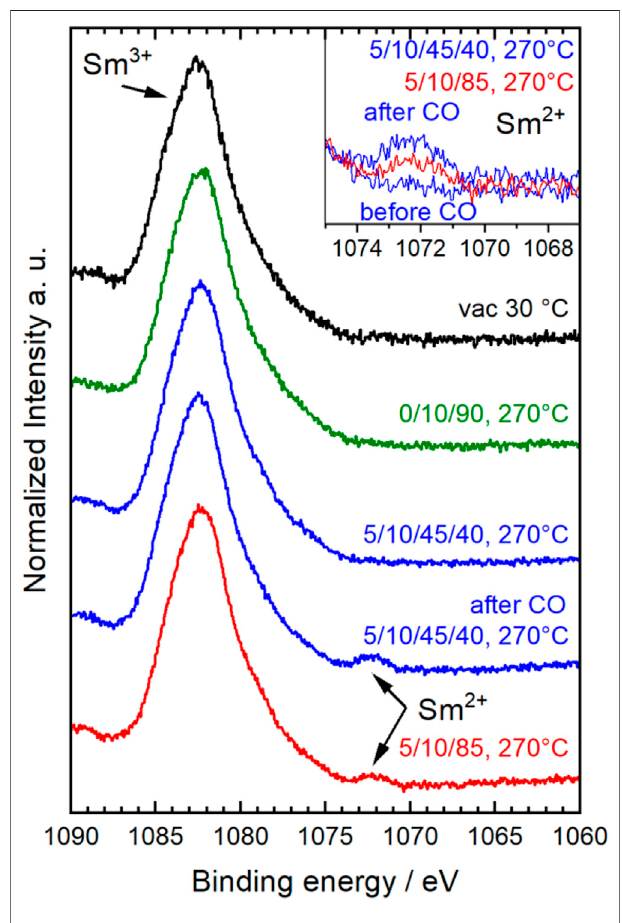
FIGURE 5 | Normalized Sm 3d 5/2 spectra of Sm 0.96 MnO 3 collected at different conditions given as C 3 H 8 /O 2 /He/H 2 O (initial – black, 10% O 2 / He – green, wet feed – blue, dry feed – red). Inset depicts selected spectra ranges to show the Sm 2+